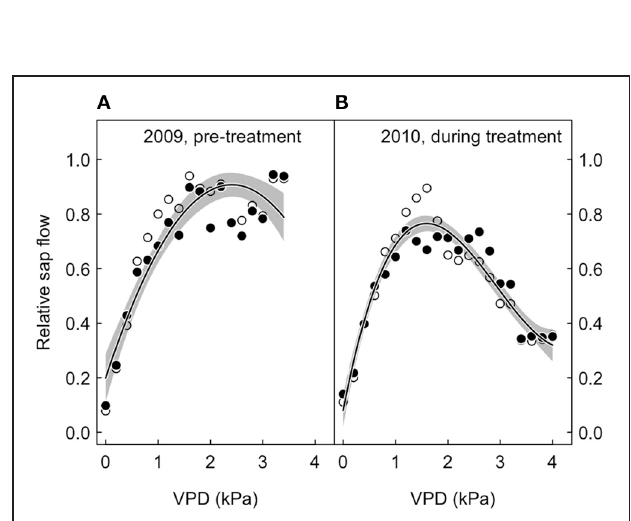
FIGURE 5 | Relative sap flow plotted against the vapor pressure deficit (VPD), according to treatment (open symbols, ambient; closed symbols, treated), before and after the initialization of the CO 2 -treatment. Shown are 95 percentile values for 2 kPa bins, with non-linear fits (solid lines) and their 95% confidence intervals (gray-shaded area around the regression line). The merged model fits (treated and control trees) are shown. (A) 2009, before the start of the CO 2 treatment. (B) 2010, during the CO 2